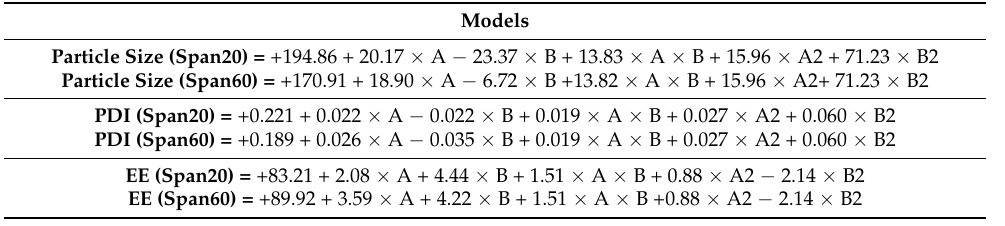
Table 3. Regression analysis results for particle entrapment efficiency, particle size, and polydispersity index (PDI) for the quadratic model.